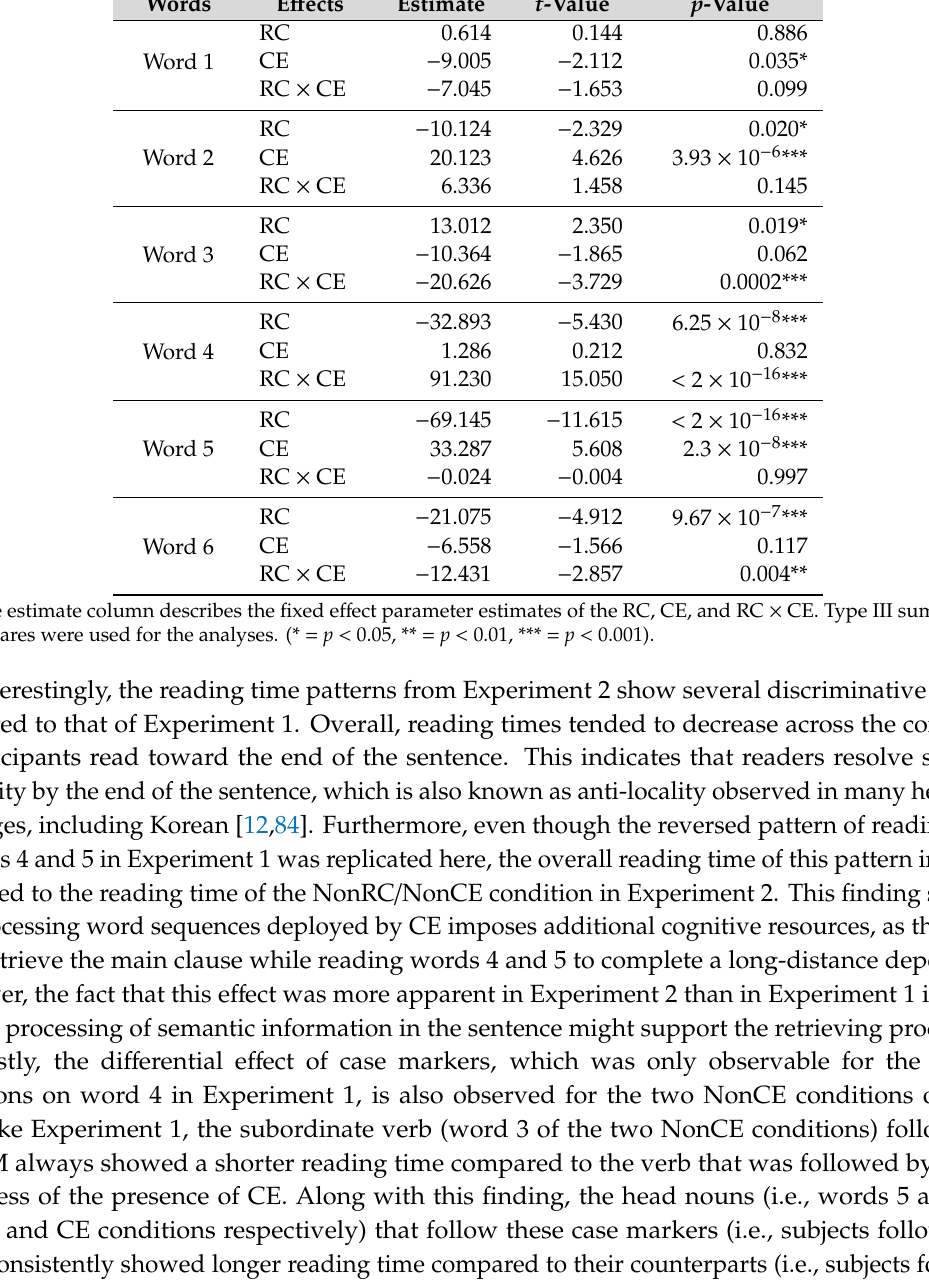
Table 5. The parameter estimates, t -values, and approximate p -values of the e ff ects from Experiment 2. Words E ff ects Estimate t